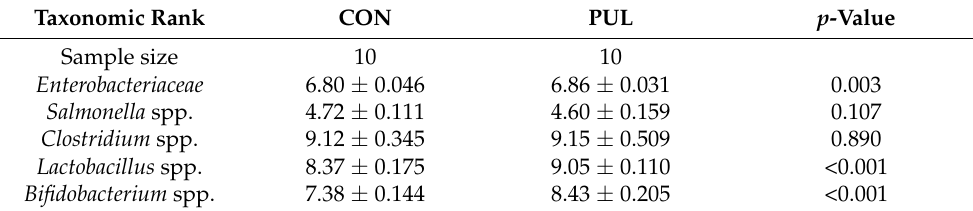
Table 6. Effect of olive pulp dietary addition on the fecal contents of Enterobacteriaceae , Salmonella spp., Clostridium spp., Lactobacillus spp., and Bifidobacterium spp. (log 10 number of copies DNA/g feces) in Iberian sows (mean ±